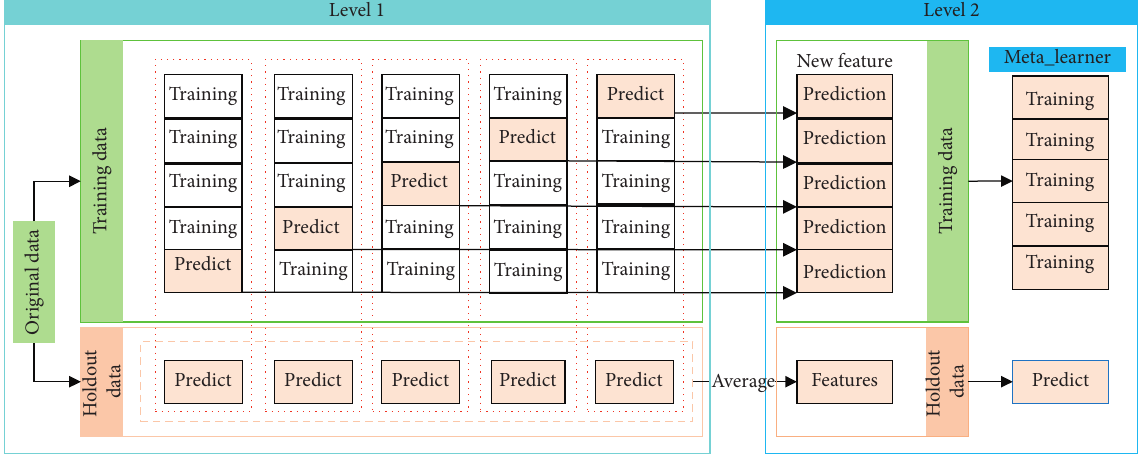
Figure 7: Description of the stacked generalization